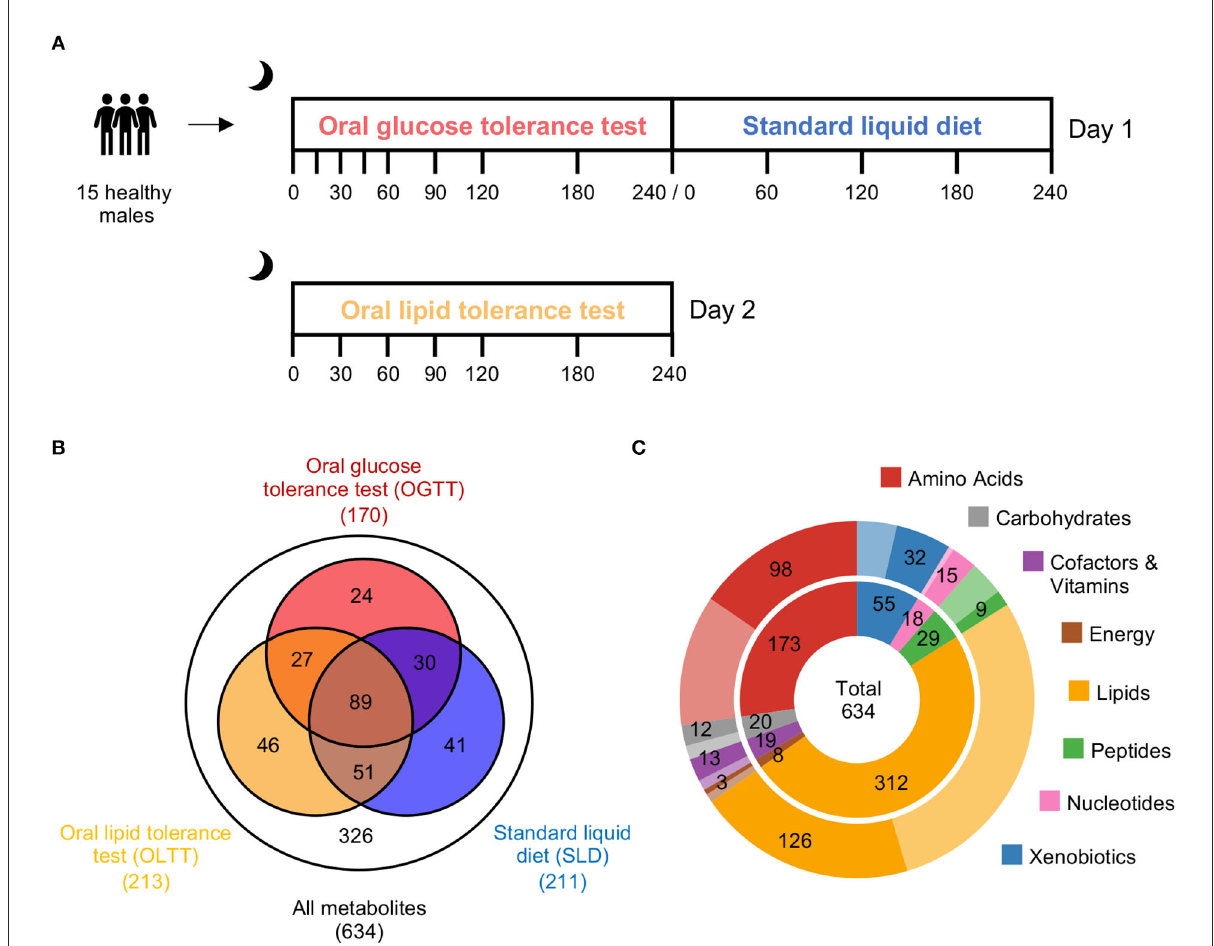
FIGURE1 Metabolic responses to three dietary challenges. (A) Fifteen young healthy male participants completed three dietary challenges. Up to eight blood plasma samples were taken from baseline to 4h postprandially in intervals from 15 to 60min. Each sample was analyzed using a non-targeted and a targeted mass spectrometry-based metabolomics approach to identify metabolites increasing or decreasing in response to a challenge in a time-resolved manner. (B) Out of 634 measured metabolites that survived data quality control, we identified those metabolites in each challenge that displayed a significant change during the 4h after ingestion of the challenge drink (based on a repeated measure ANOVA-type statistics; Bonferroni adjusted p < 0.05). The Venn diagram illustrates the number of overlapping and unique metabolites with significant responses to the challenges with 89 metabolites that showed changes irrespective of the composition of the meal. (C) The 308 metabolites with significant postprandial responses are distributed over the 8 investigated metabolite classes (saturated color in the outer circle indicates the portion of significant metabolites in the respective class in relation to the number of metabolites measured from this class, which is shown in the inner